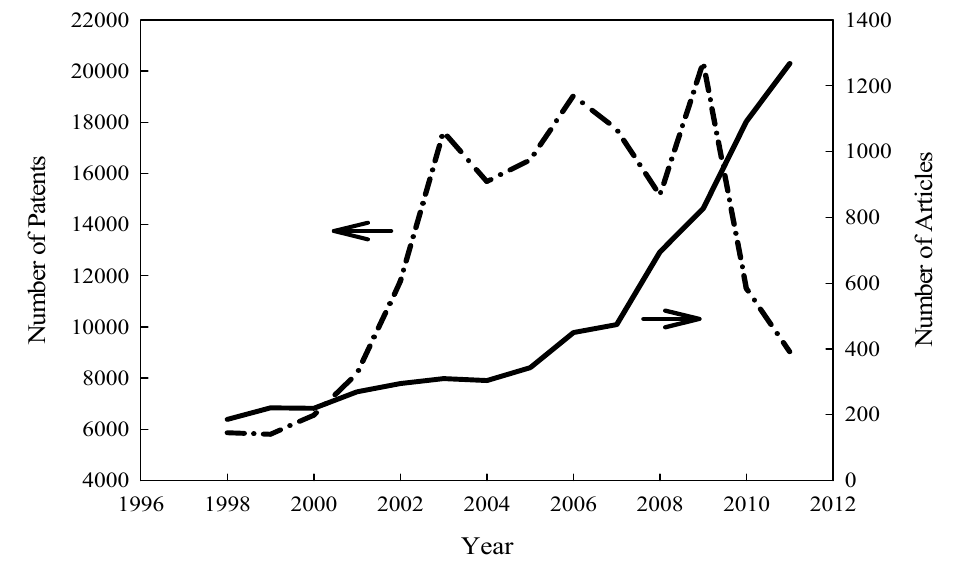
Figure 2. Trend in number of patents (dash-dot line) and publications (solid line) since 1998. Research done on Scopus with key words: ethanol dehydration and ethylene, ethanol dehydration and ethene, ethanol and ethylene production. Total results per type per year for the three searches were summed together.